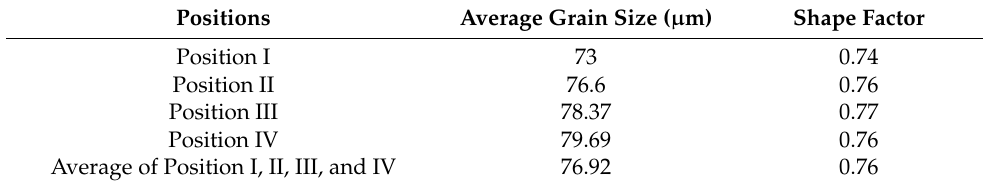
Table 4. Average grain size and shape factor of solid grain at the four different